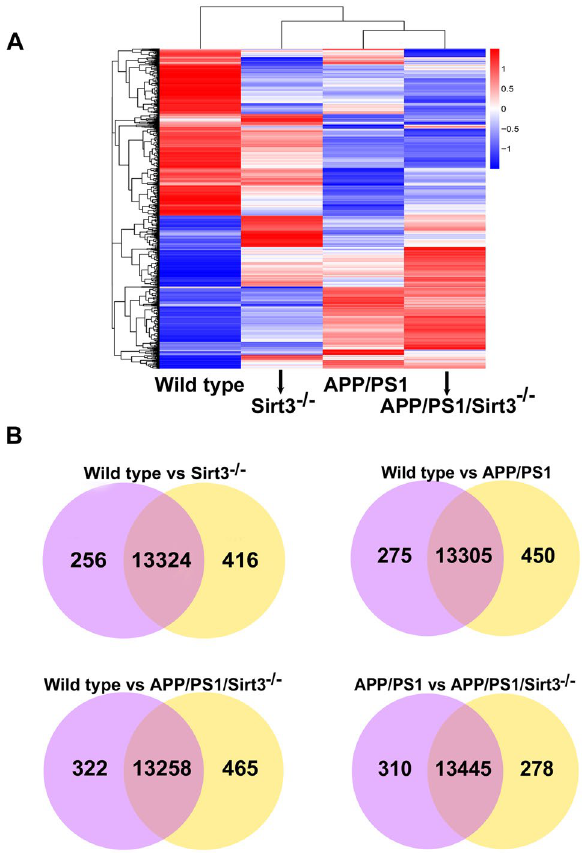
Figure 1. Heat map and Venn diagrams. Total RNA was isolated from the brain samples of 8 mo-old female mice (4 each) in wild type, Sirt3 -/- , APP/PS1 and APP/PS1/Sirt3 -/- mice. After quality control, mRNA was purified, sheared into short fragments of ~ 200 bases and used as templates for cDNA synthesis, followed by library preparation. The cDNA libraries were sequenced (25 million reads), using Illumina NexSeq550 platform. RNA-seq reads were mapped to the mouse genome, using TopHat software. The heat map of cluster analysis ( A ) shows significant changes in the gene expression patterns between the groups. Unique and overlapping gene expressions between groups are shown by Venn diagrams ( B